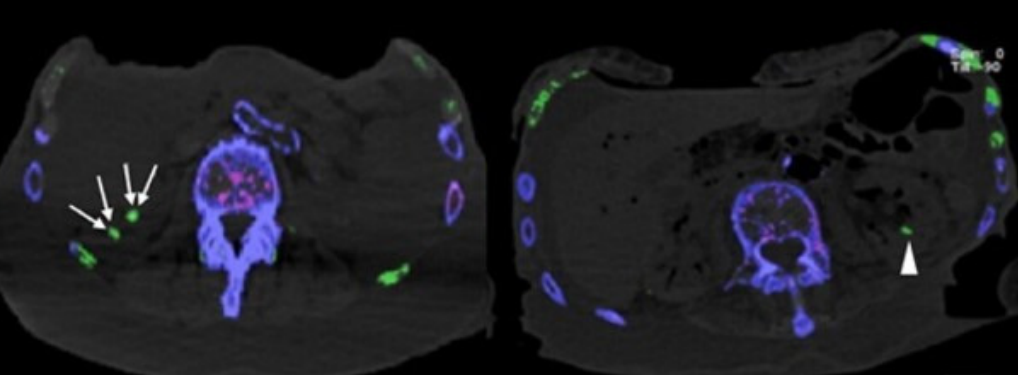
Figure 4. Axial DECT images showing MSU deposits in kidney stones (white arrows) and MSU deposit in renal calyx (arrowhead).